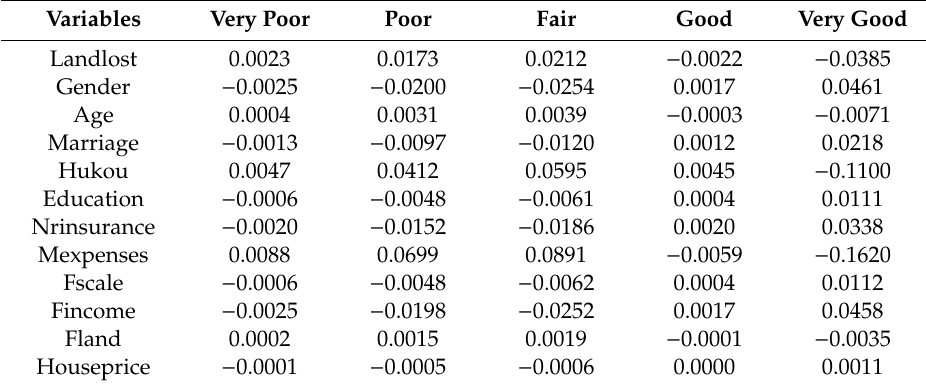
Table 3. Marginal e ff ect of ordered probit estimations of health